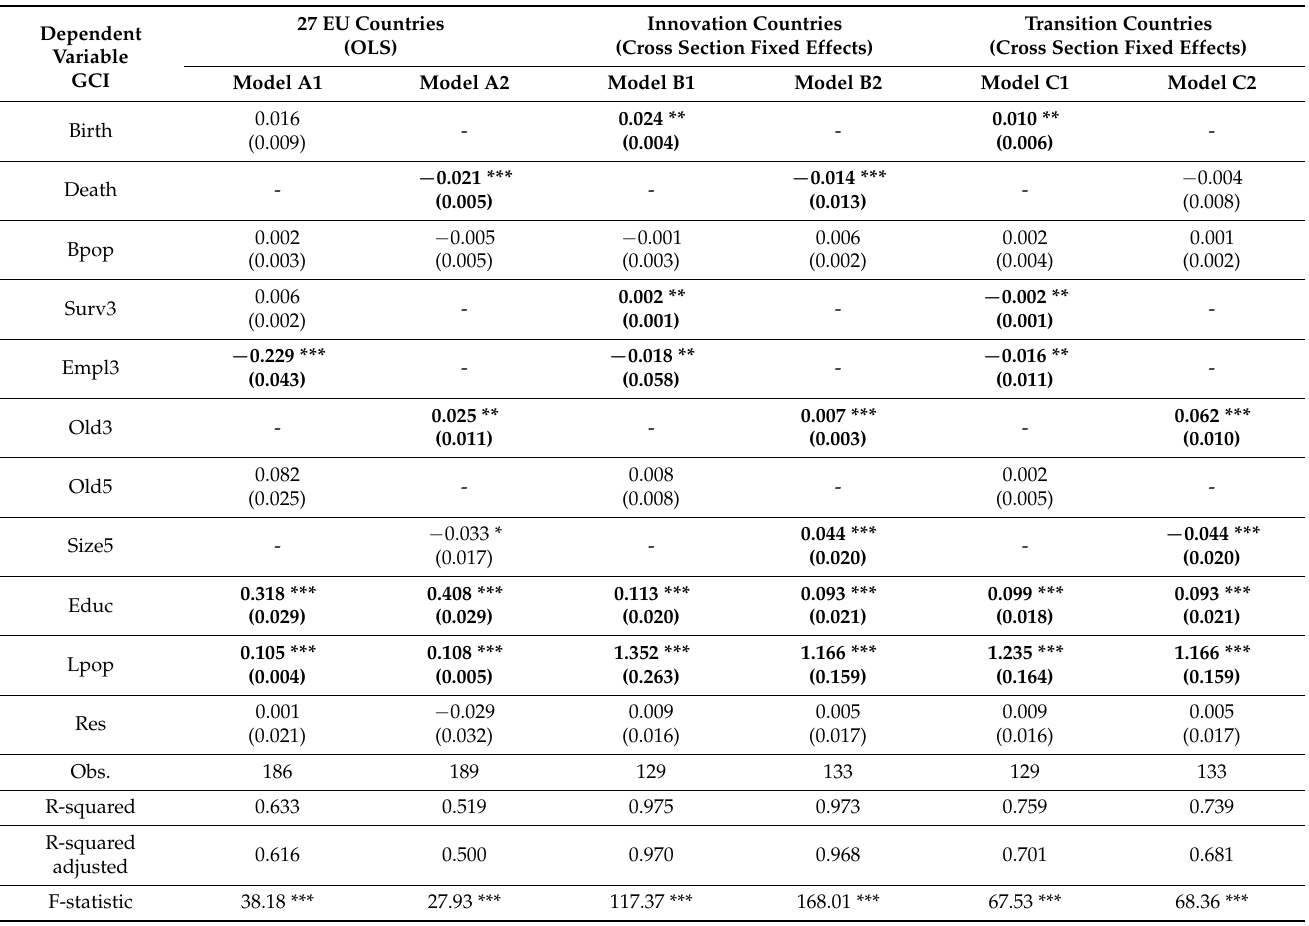
Table 5. Effects of entrepreneurial performance on